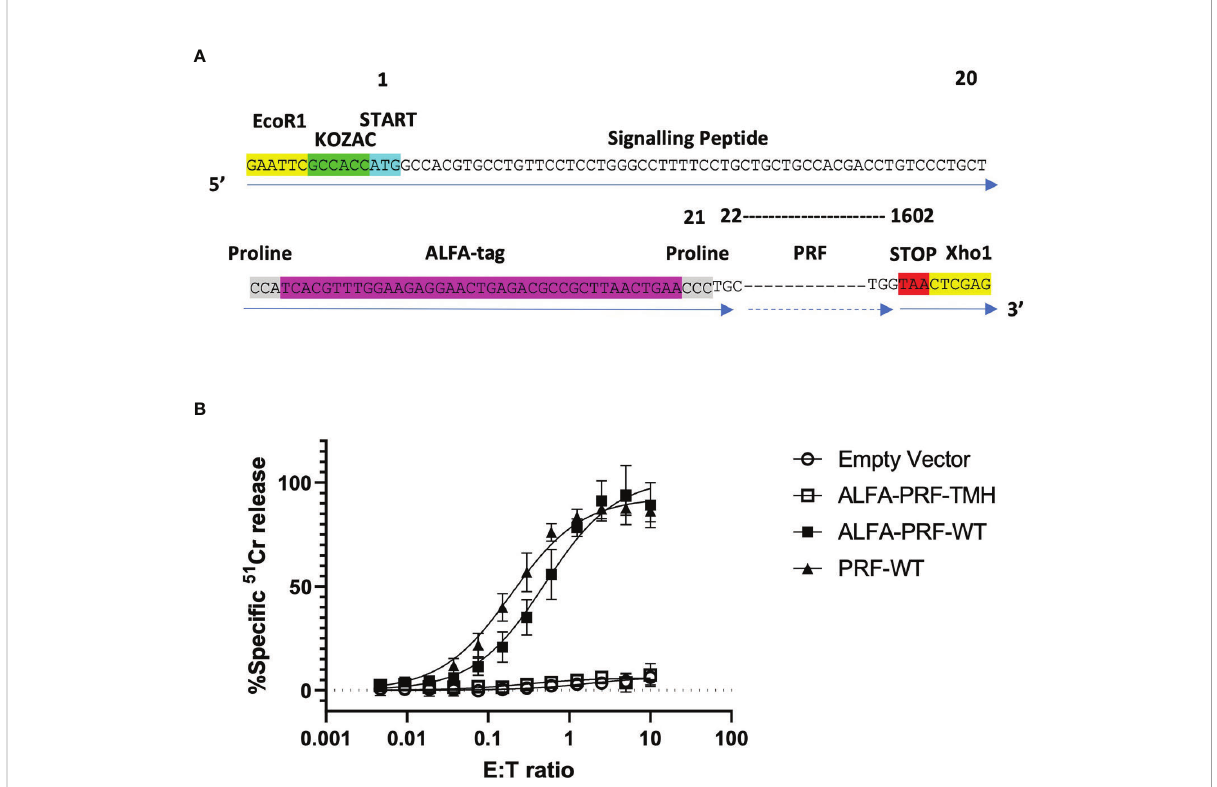
FIGURE 2 WT ALFA-PRF retains cytolytic function. (A) ALFA-tag sequence fl anked by prolines is designed to reside immediately following the cleavable signalling peptide of perforin is cloned into MSCV-TagBFP using the restriction enzyme cut sites EcoR1 and Xho1. (B) Transduction of non- cytotoxic Prf1 -/- .OT1 T cells with PRF-WT and ALFA-PRF-WT restores their killing capacity, while ALFA-PRF-TMH ( ‘ disulphide locked ’ perforin mutant) and Empty Vector do not restore function. N=3-6, error bars represent s.e.m. Individual values are shown in Supplementary Table